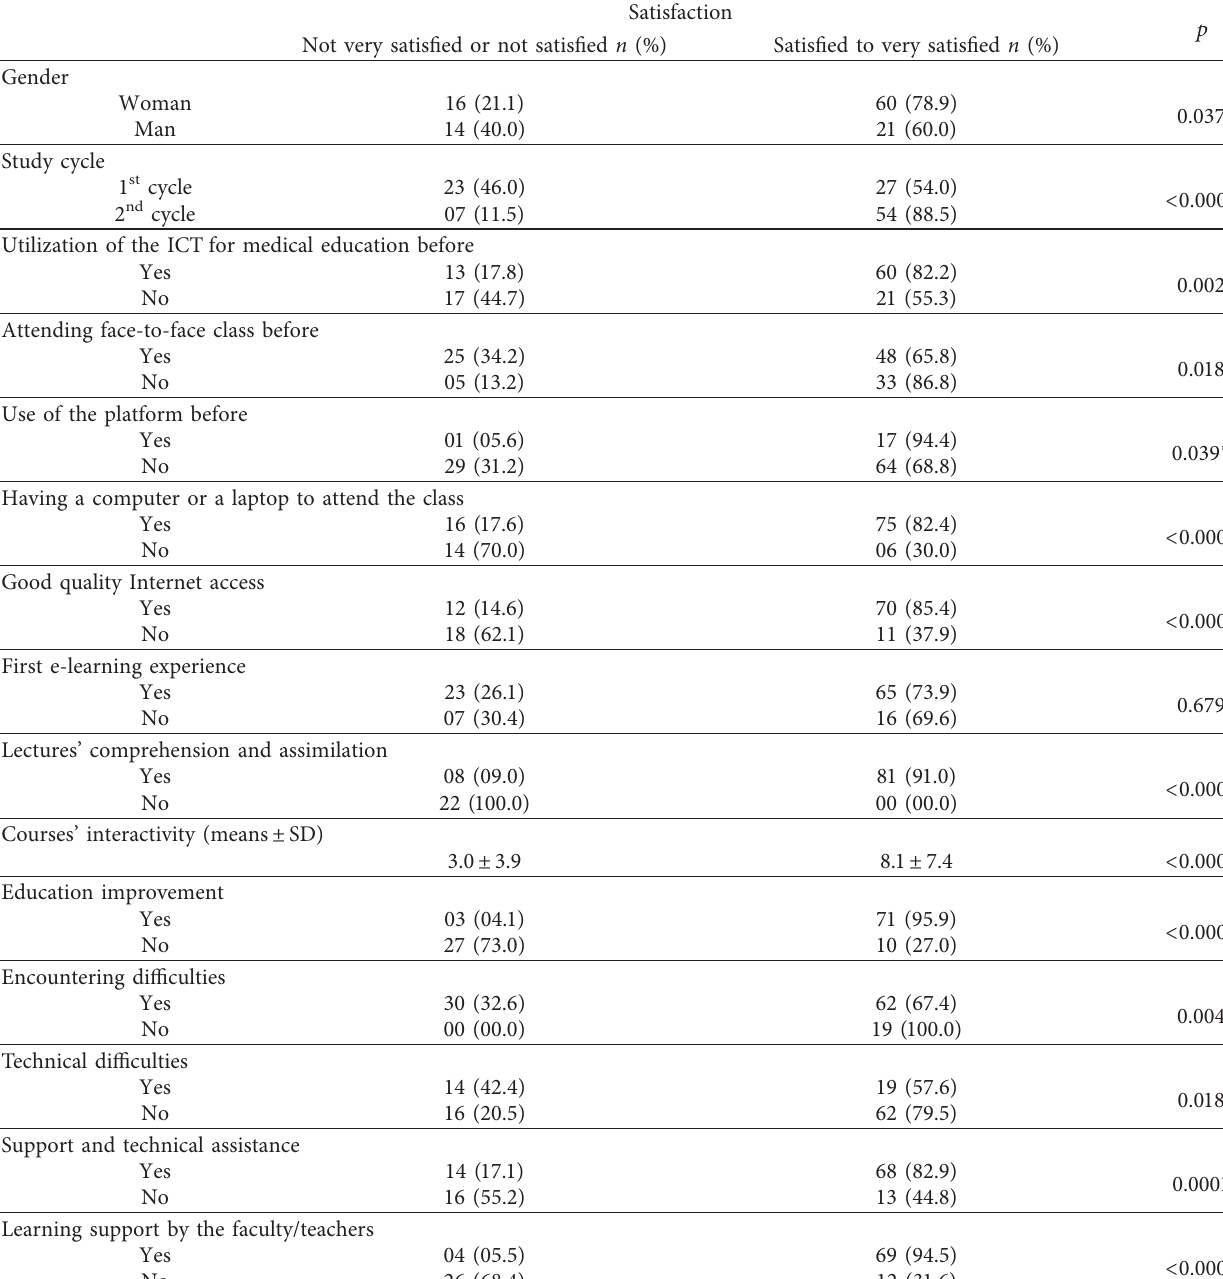
Table 4: Factors associated with the distance learning satisfaction among the students.